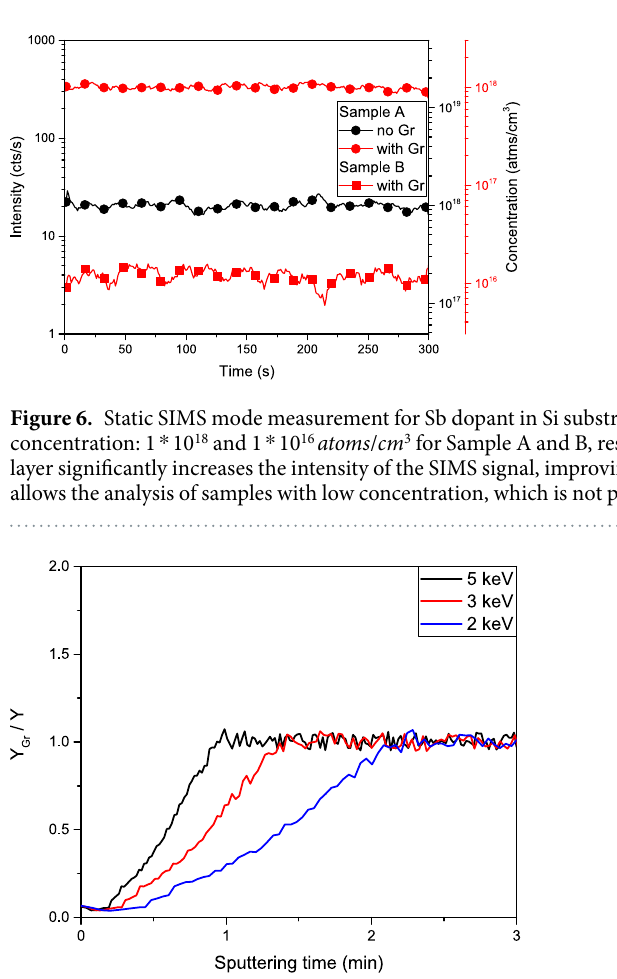
Figure 7. The gain change during sputtering in dSIMS mode for Ga + ions in GaAs substrate. In positive ion detection, no enhancement effect is observed, only the blocking effect of graphene. The positive ionization probability remains the same for the whole experiment and thus the Y Gr / Y ratio is being monitored. For smaller impact energies lower sputter rate is